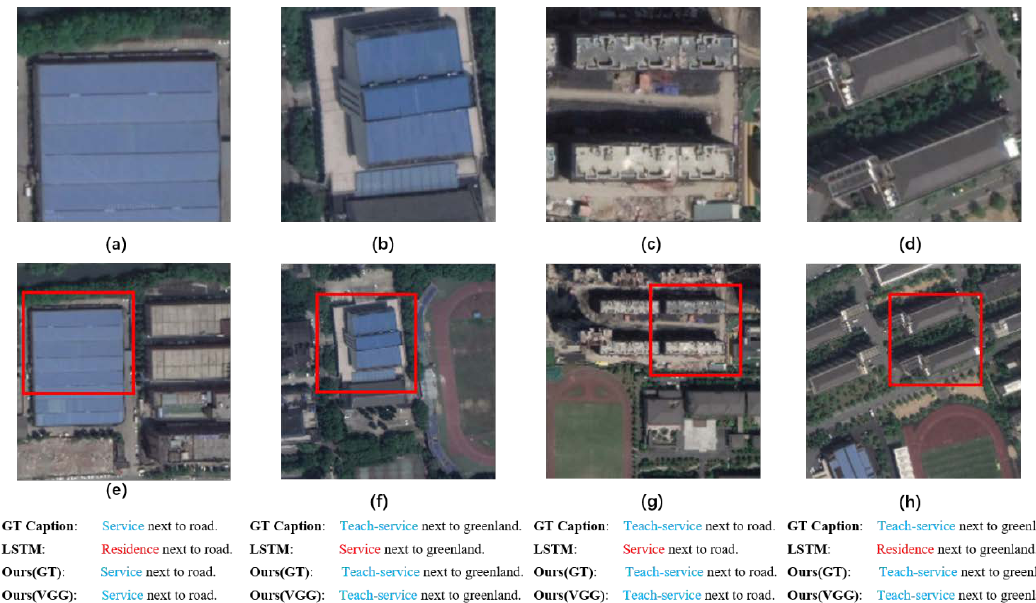
Figure 5. Three network generated image caption sentences and GT caption sentence. ( a – d ) are four small-scale samples; ( e – h ) are corresponding large-scale samples of ( a – d ).